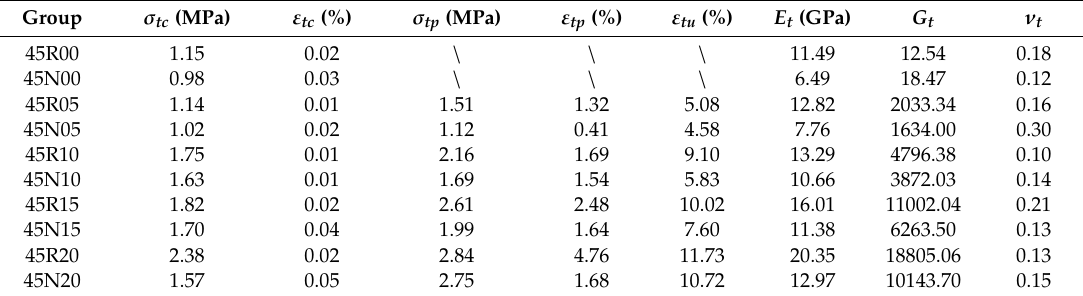
Figure 14. CT images on specimens after axial tensile test. Table 6. Tensile